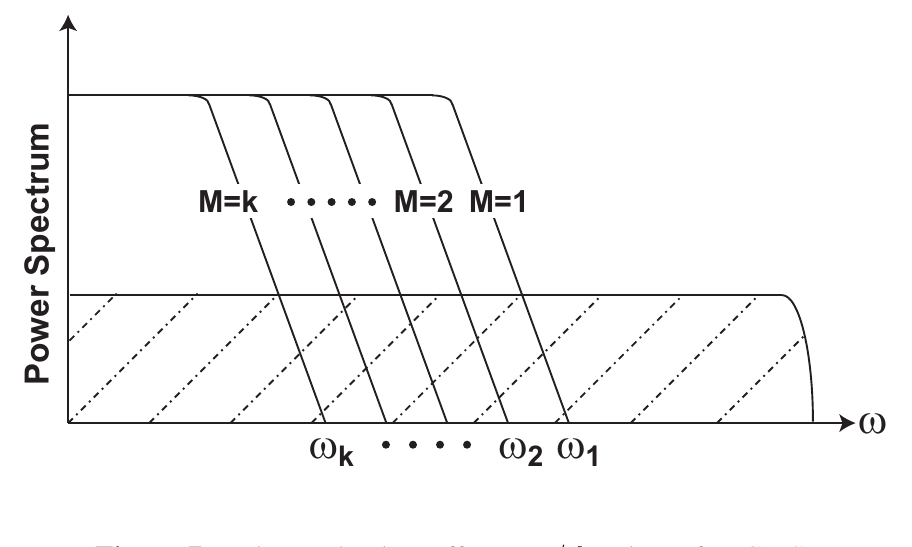
Figure 7. Noise Reduction Effect to 1 /f Noises after CMS.